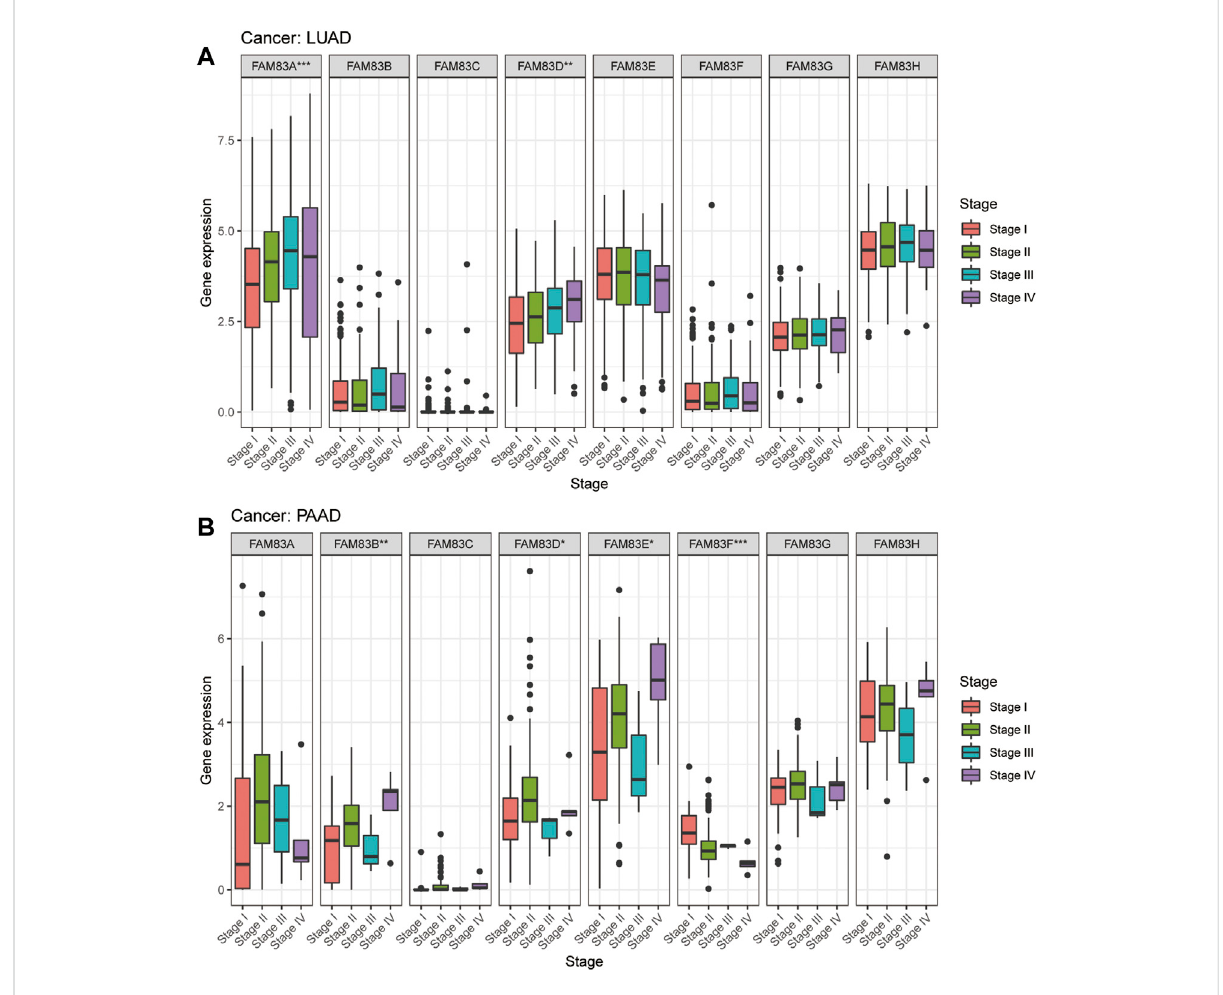
FIGURE 4 Expression analysis of FAM83 family genes in cancer staging. (A) LUAD. (B) PAAD. (*** p < 0.001; ** p < 0.01; * p <